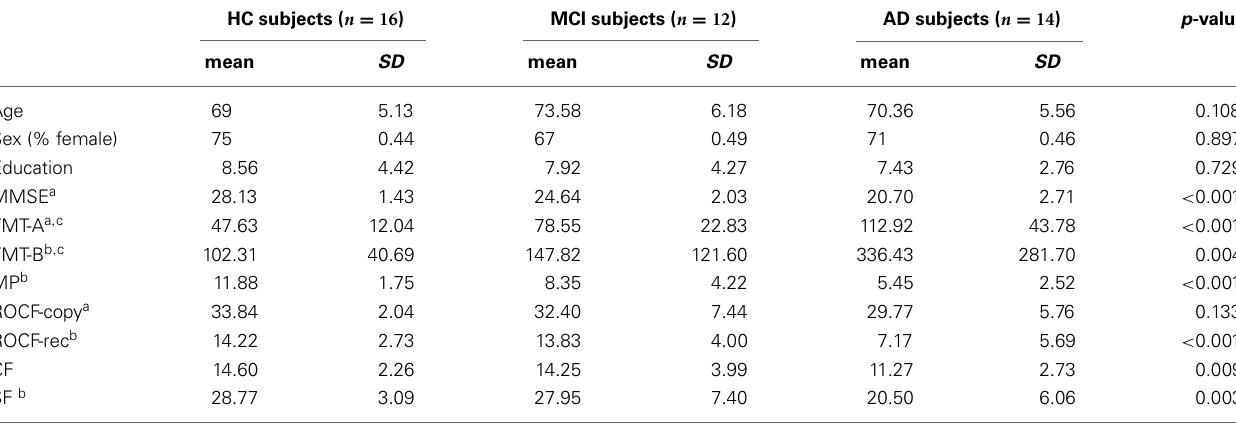
The tablereports, for the AD, MCI, and HCgroups, the score values (mean andSD) for different neuropsychological test comprising the mini mental stateexamination (MMSE), trial making test part A and B (TMT-A and TMT-B), memory for prose (MP), category fluency (CF) and semantic fluency (SF), Rey complex figure copy test (ROCF-copy) and Rey complex figure recall (ROCF-rec). p-values show statistically significant differences between the HC, MCI and AD groups. * p < 0 .